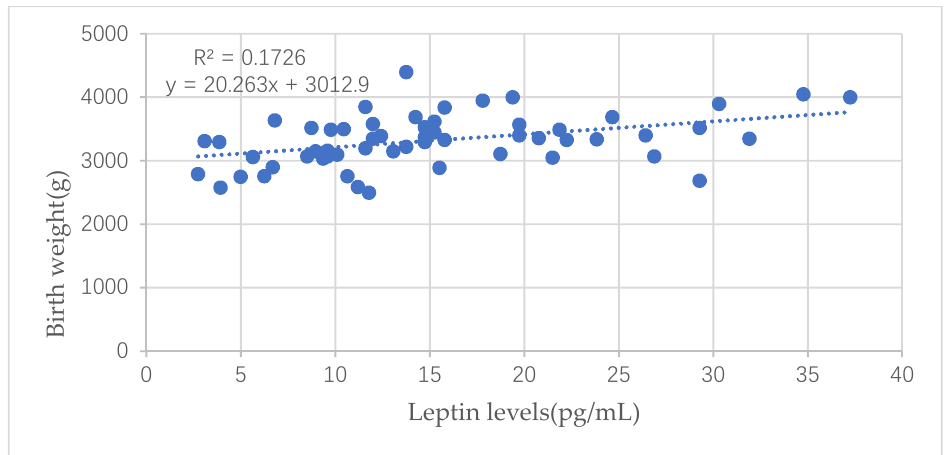
3012.9R² = 0.1726 y = 20.263x +